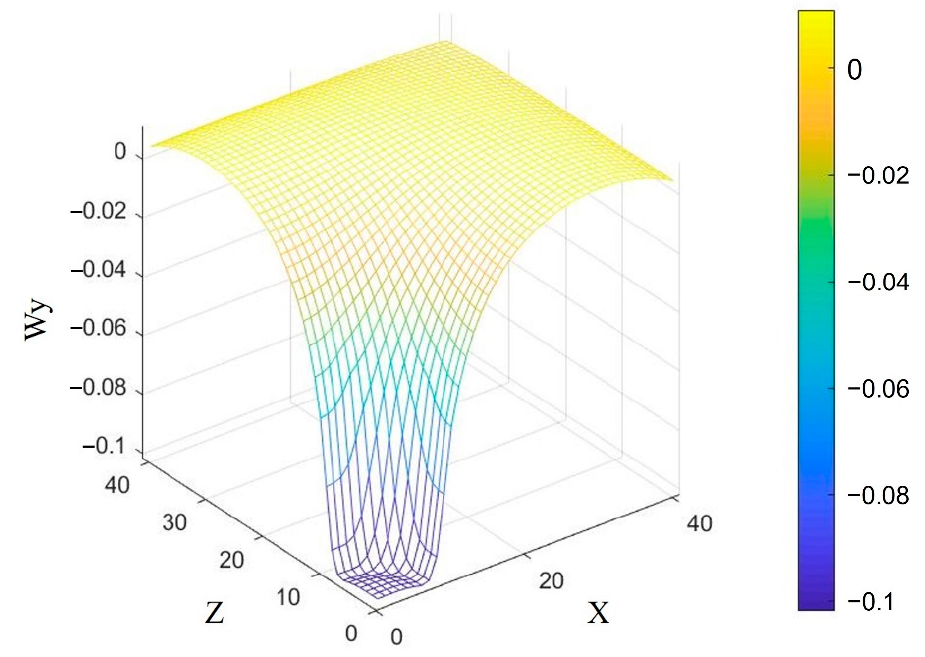
Figure 4. Displacement in the Y direction of the extracellular space, w y , at the Y = 1 surface for ε = 0.0001 .